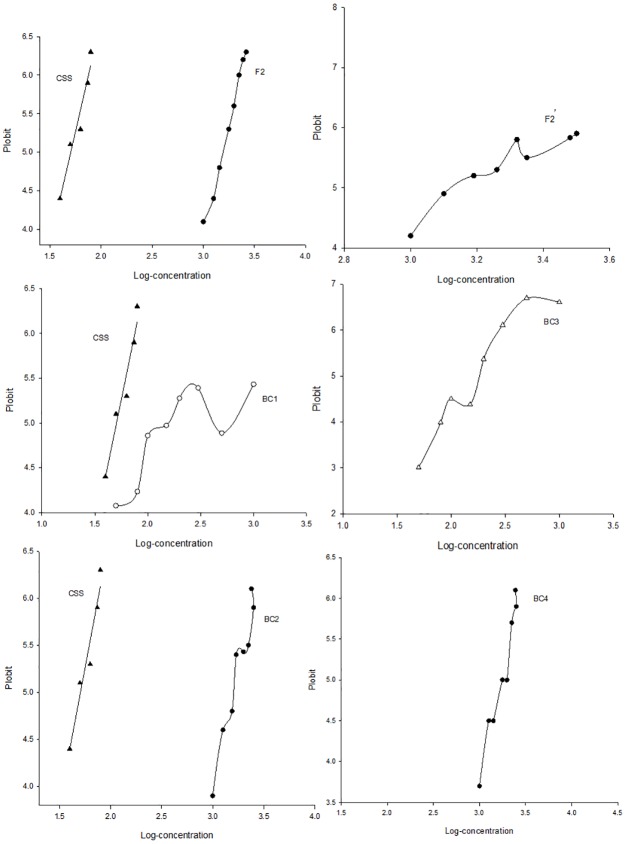
Log concentration-probit lines for the (▲) susceptible strain (CSS), backcrossed progenies (○) BC1, (◆) BC2, (Δ) BC3, (★) BC4 and self-bred progenies (●) F2, (■) F2’.